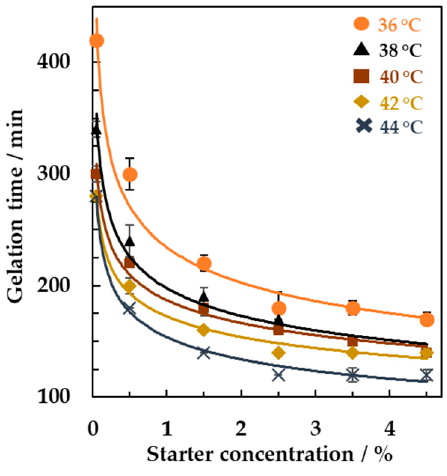
Figure 4. Gelation time obtained from backscattering signals versus different concentrations of yogurt starter as a function of the incubation temperature.